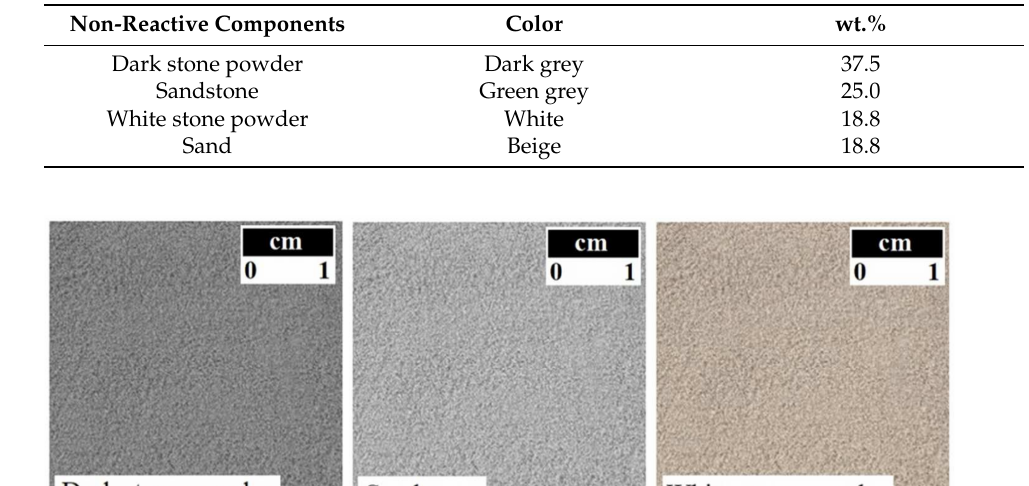
Table 1. The composition of the non-reactive part of the mortars.